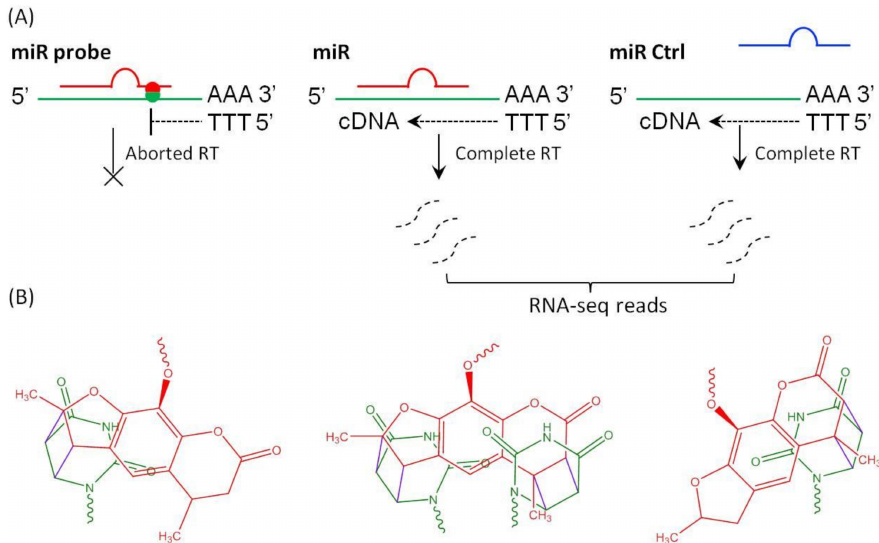
Figure 1. Schematic illustration of photo crosslinking products of the probe and reverse transcription of poly(A) RNA from miR transfected cells. ( A ) Psoralen functionalized miR probe covalently crosslinks to the target mRNA and terminates reverse transcription. RT reaction on miR-mRNA complex is aborted (left), yielding less reads; while control miR (right) or wildtype miR (middle) promotes complete RT reaction and produces equal quantity of RNA-seq reads. ( B ) Photo-addition of psoralen moiety of miR probe to pyrimidine on complimentary sequence of target mRNA produces furan-side monoadduct, pyrine-side monoadduct or diadduct